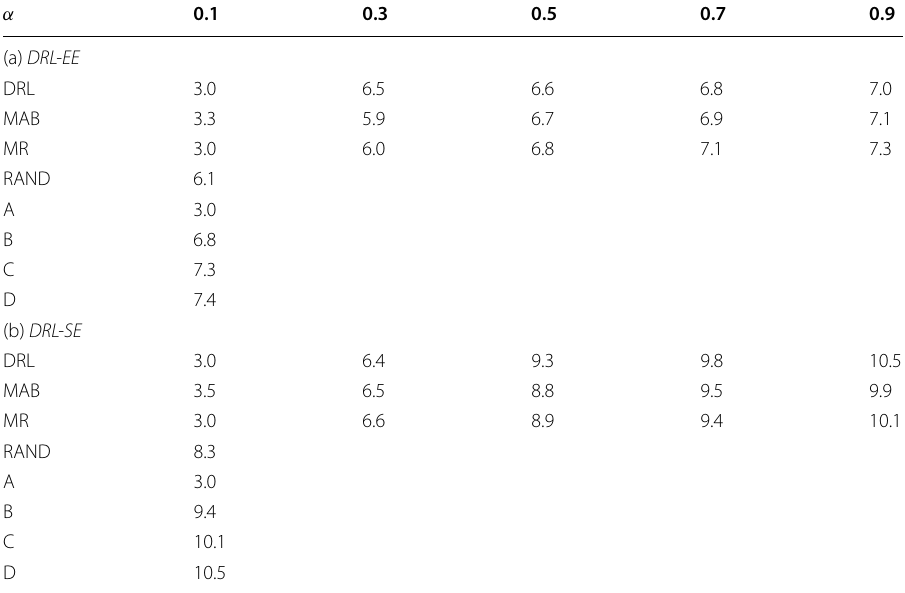
Table 6 The average number of RF chains required for DRL-EE and DRL-SE, respectively, with different trade-off factors